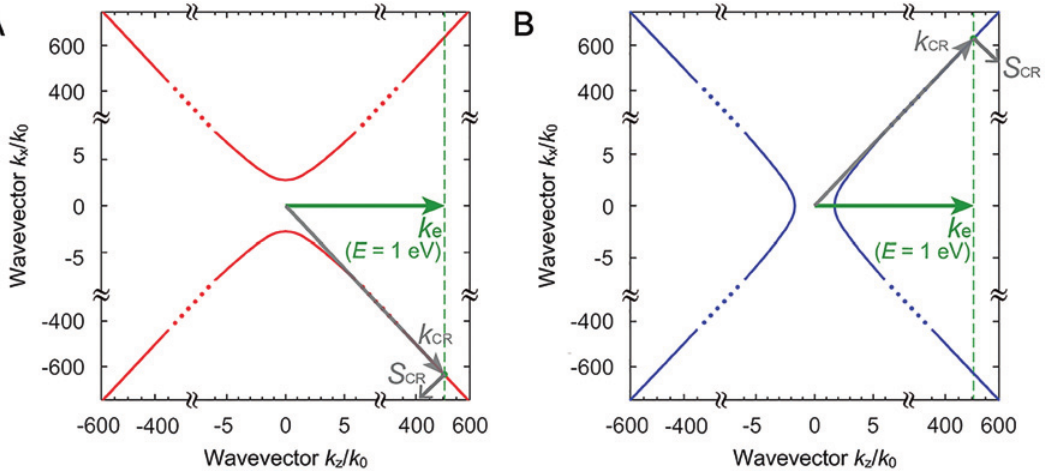
Figure 2: Wavevectors of CR in hBN at frequencies (A) ω = 800 cm – 1 and (B) ω = 1500 cm − 1 . Red and blue curves are iso-frequency contours for HPP-based CR at the two frequencies, respectively. Green arrows k e represent wavevectors of evanescent waves surrounding free electrons with energy E = 1 eV. Through wavevector matching, wavevectors of CR ( k CR ) in hBN can be obtained.Directions of Poyntingvectors of CR ( S CR ) are also